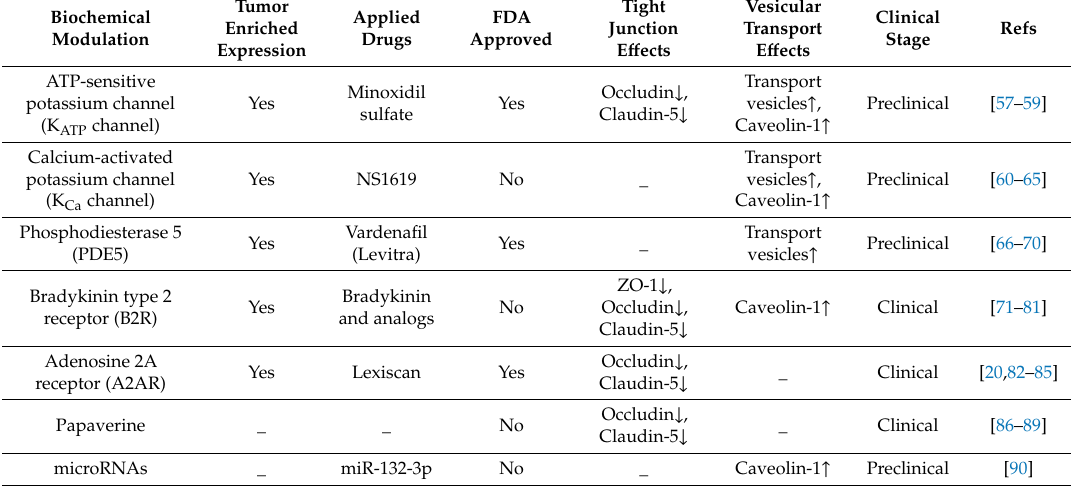
Table 1. Selective biochemical modulation for circumventing the tumor BBB in treating glioma. Biochemical